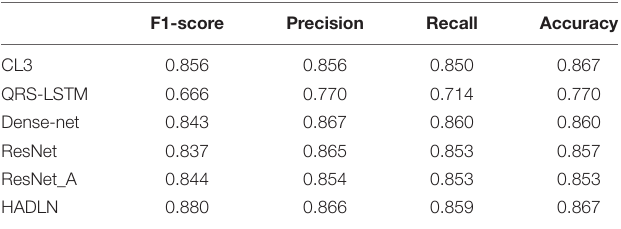
TABLE 4 | Classification results of weight average. F1-score Precision Recall Accuracy